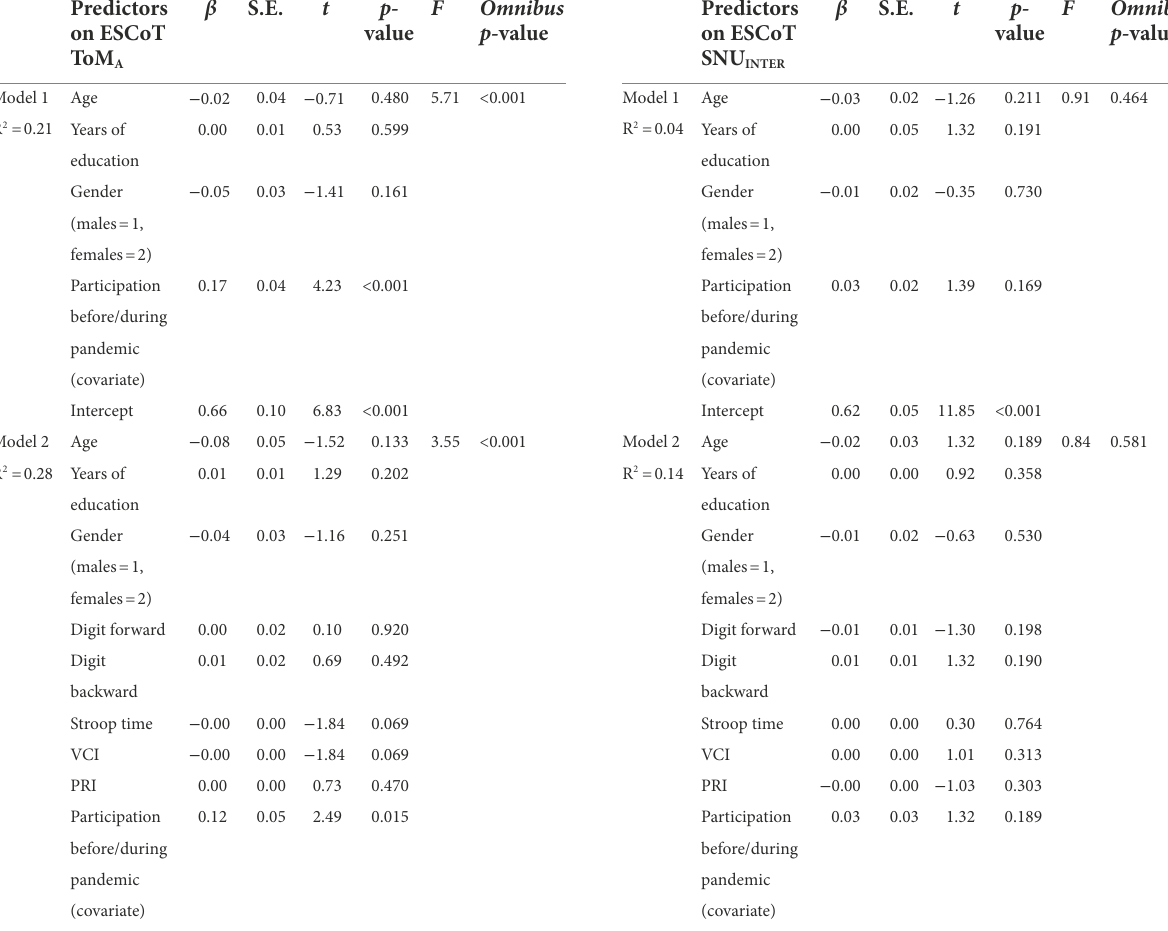
TABLE 5 Multiple regression results for predictors of ESCoT ToM A total score.